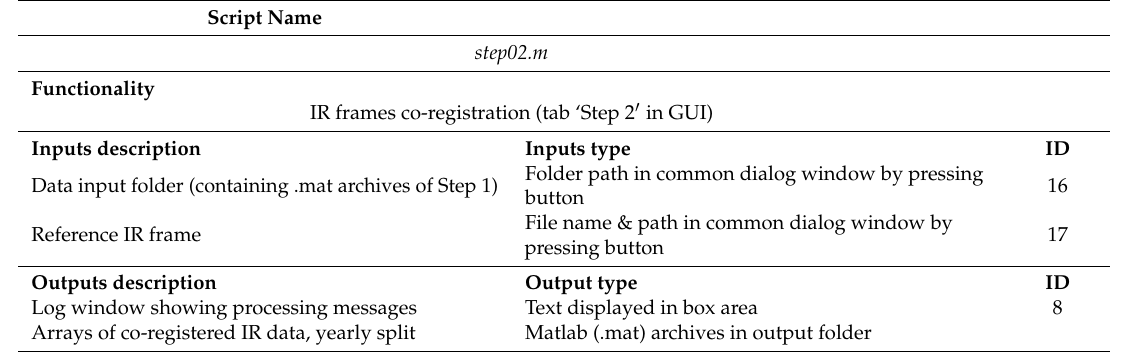
Table A3. Technical specifications of functionality and input/output data type of STEP 2.